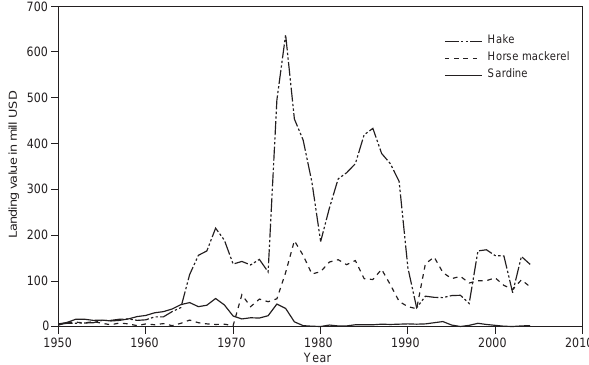
Fig. 10. Landing value of sardine (solid line), horse mackerel (dashed line) and hake (dashed and dotted line) in million US$ during the last 50 years in the Namibian EEZ (Source: www.